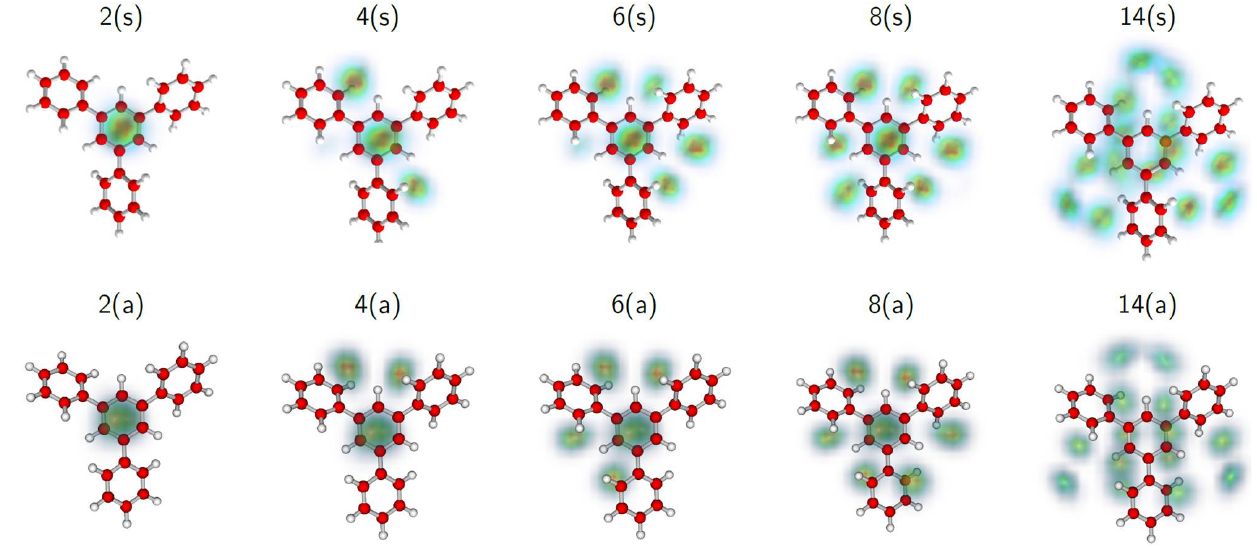
Figure 7. Selected structures of He n TPB + clusters with n = 2, 4, 6, 8, and 14, for isomers (s) and (a). For each size, the helium densities obtained from the PIMD simulations are superimposed on the structure of TPB +